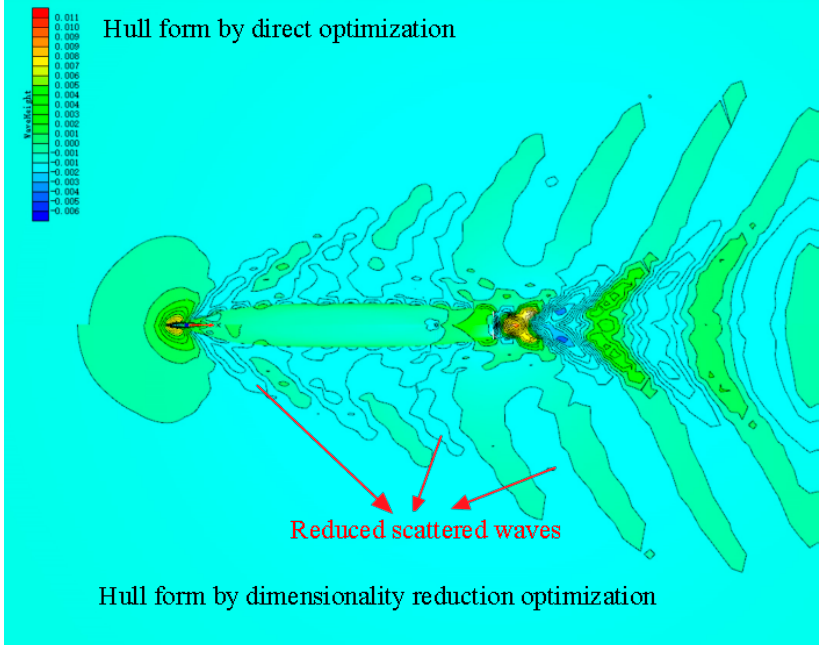
Figure 26. Comparison of wave disturbances of original hull form and hull form obtained by di- mensionality reduction optimization.